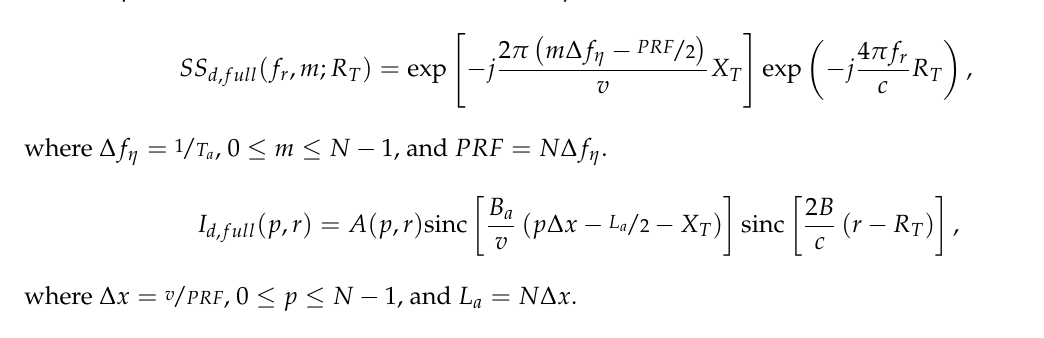
Table 1. Notations used in the full aperture